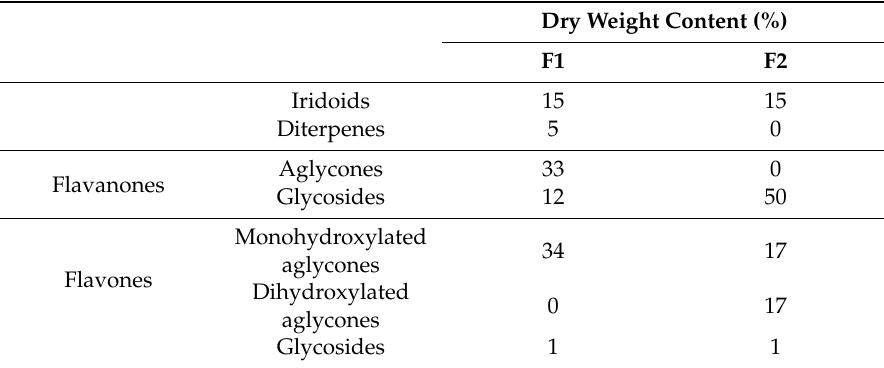
Table 1. Analytical composition in bioactive compounds (dry weight) for the formulations F1 and F2 as declared by the manufacturer. Both formulations were composed of citrus and olive extracts while F1 also contained rosemary